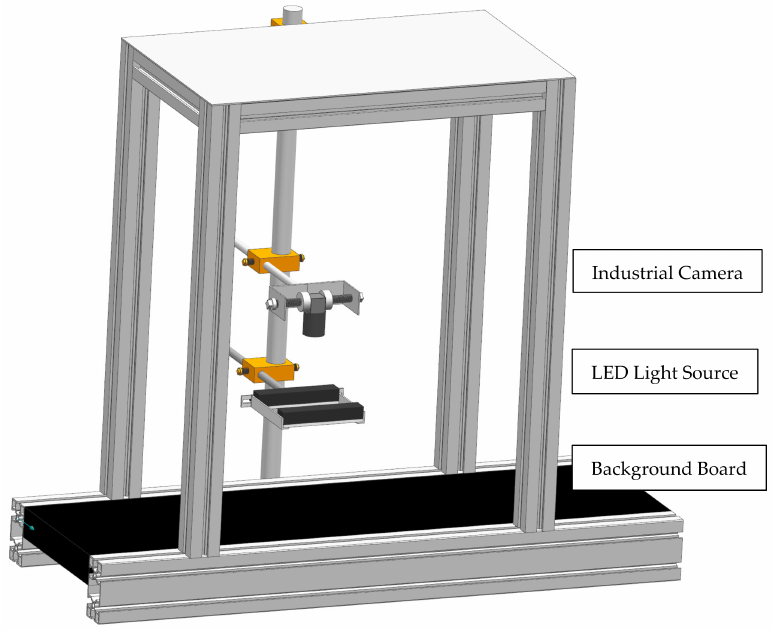
Figure 2. Vision acquisition